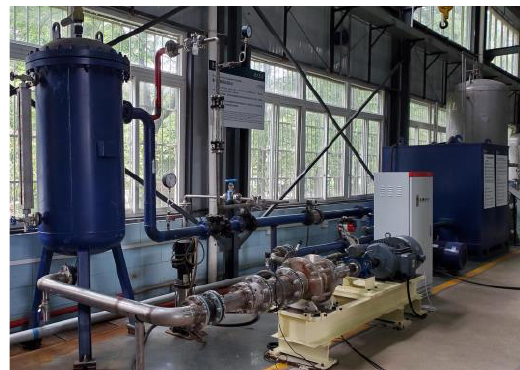
Figure 3. Multiphase test system. Table 3. Main parameters of multiphase